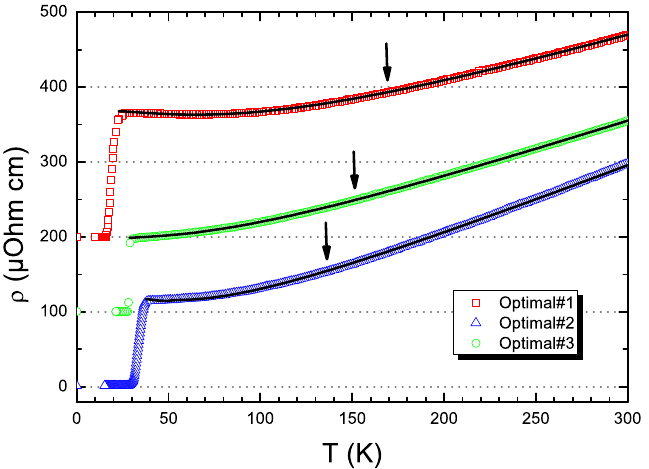
Figure 2. (Color online) Resistivity curves for three selected SLCO samples with an electronic doping close to the optimal condition. The best fit curves are also reported. Arrows indicate the temperatures below which the resistivity curves are no longer purely linear, namely T L . Data are shifted 100 µ Ohm · cm for